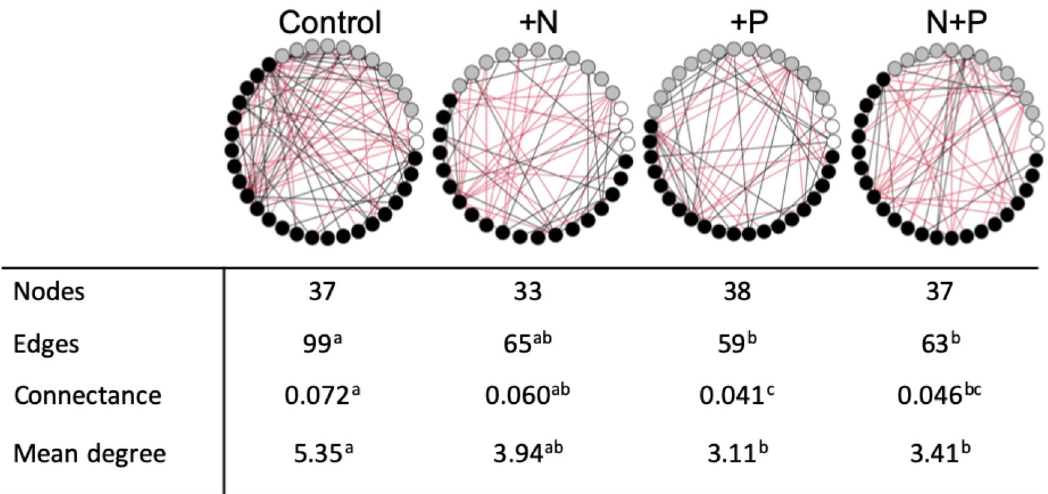
Fig. 3 Co-occurrence network analyses on fungal genera belonging to mutualists (white circles), pathogens (gray circles), and saprotrophs (black circles). The number of nodes is the number of genera that had signi fi cant correlations with other genera, edges represent the number of signi fi cant correlations (positive indicated by black and negative indicated by red), connectance is the proportion of all possible edges that are present in each network, calculated as (number of edges)/(number of nodes) 2 , and mean degree is the average number of edges per node. Different superscript letters indicate statistically signi fi cant differences. All 25 sites were included in the co-occurrence analysis.